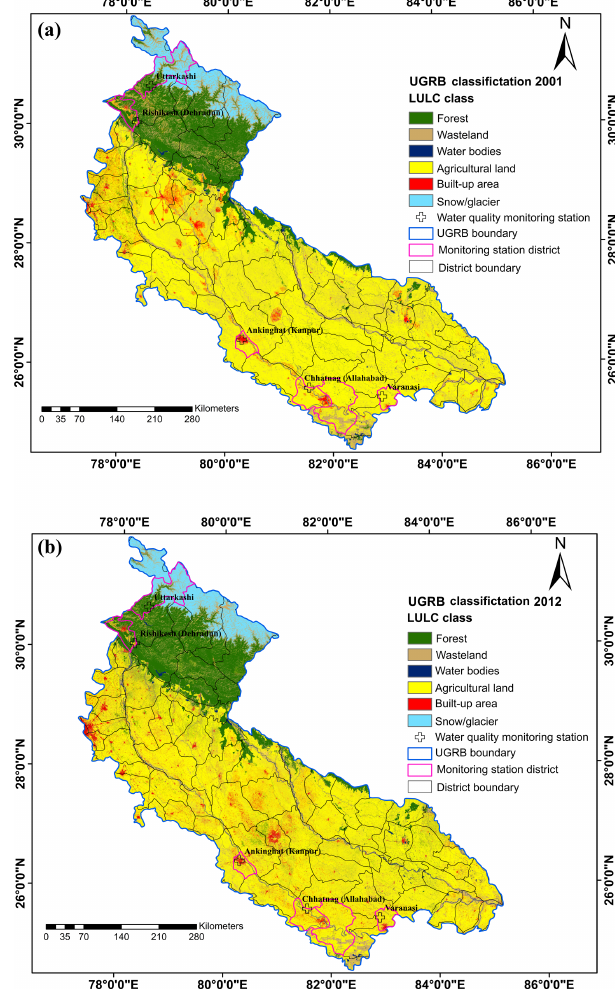
Figure 4. LULC maps of Upper Ganga River basin. (a) LULC map of February–March 2001 and (b) LULC map of February–March